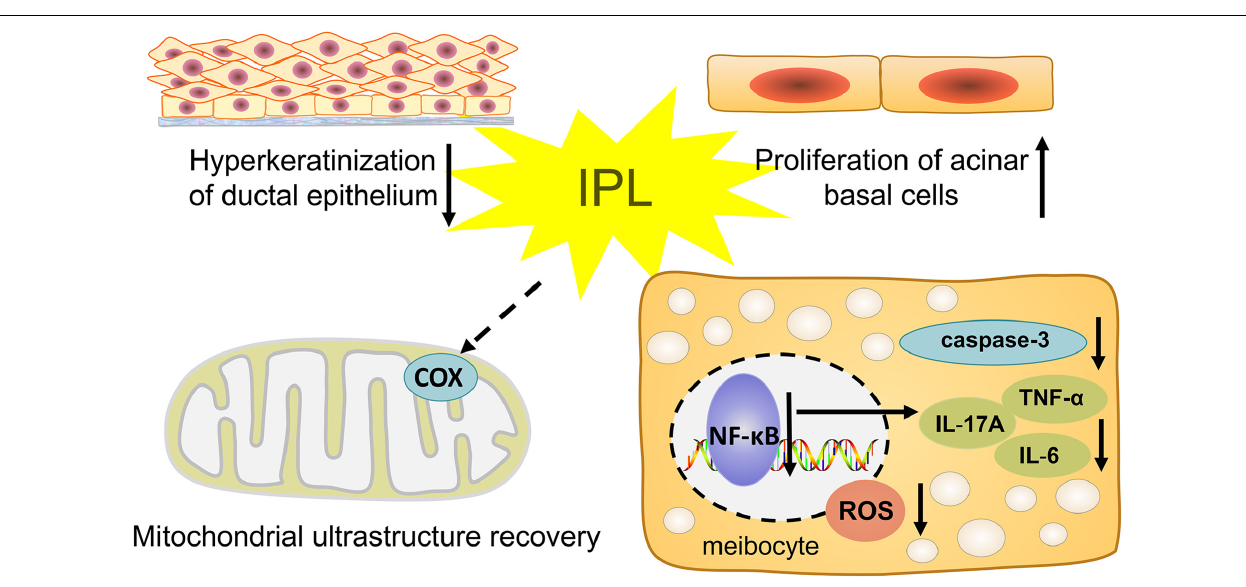
FIGURE 7 | Illustration of the hypothetical mechanisms of indirect effects of IPL on